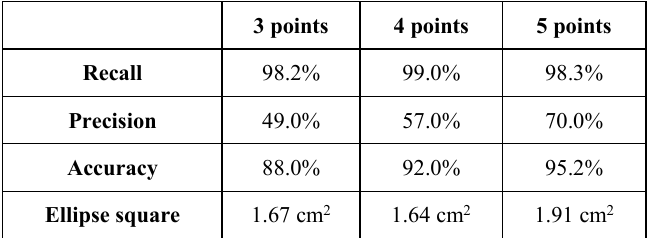
Table 1. The results of applying several metrics on the trained network for different input length 3